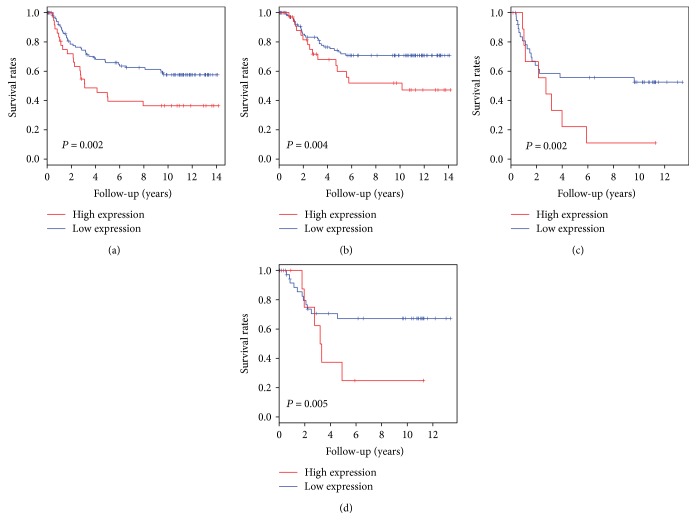
Kaplan-Meier curves for patient survival. Patients with a high Cav-1 metastatic tumor showed a significantly shorter relapse-free survival (a) and cancer-specific survival (b) after surgery than those with a low Cav-1 tumor (P = 0.002 and P = 0.004, resp.). In patients with lymph node metastasis, high metastatic tumoral Cav-1 expression was associated with shorter relapse-free survival (c) and cancer-specific survival times (d) (P = 0.002 and P = 0.005, resp.).